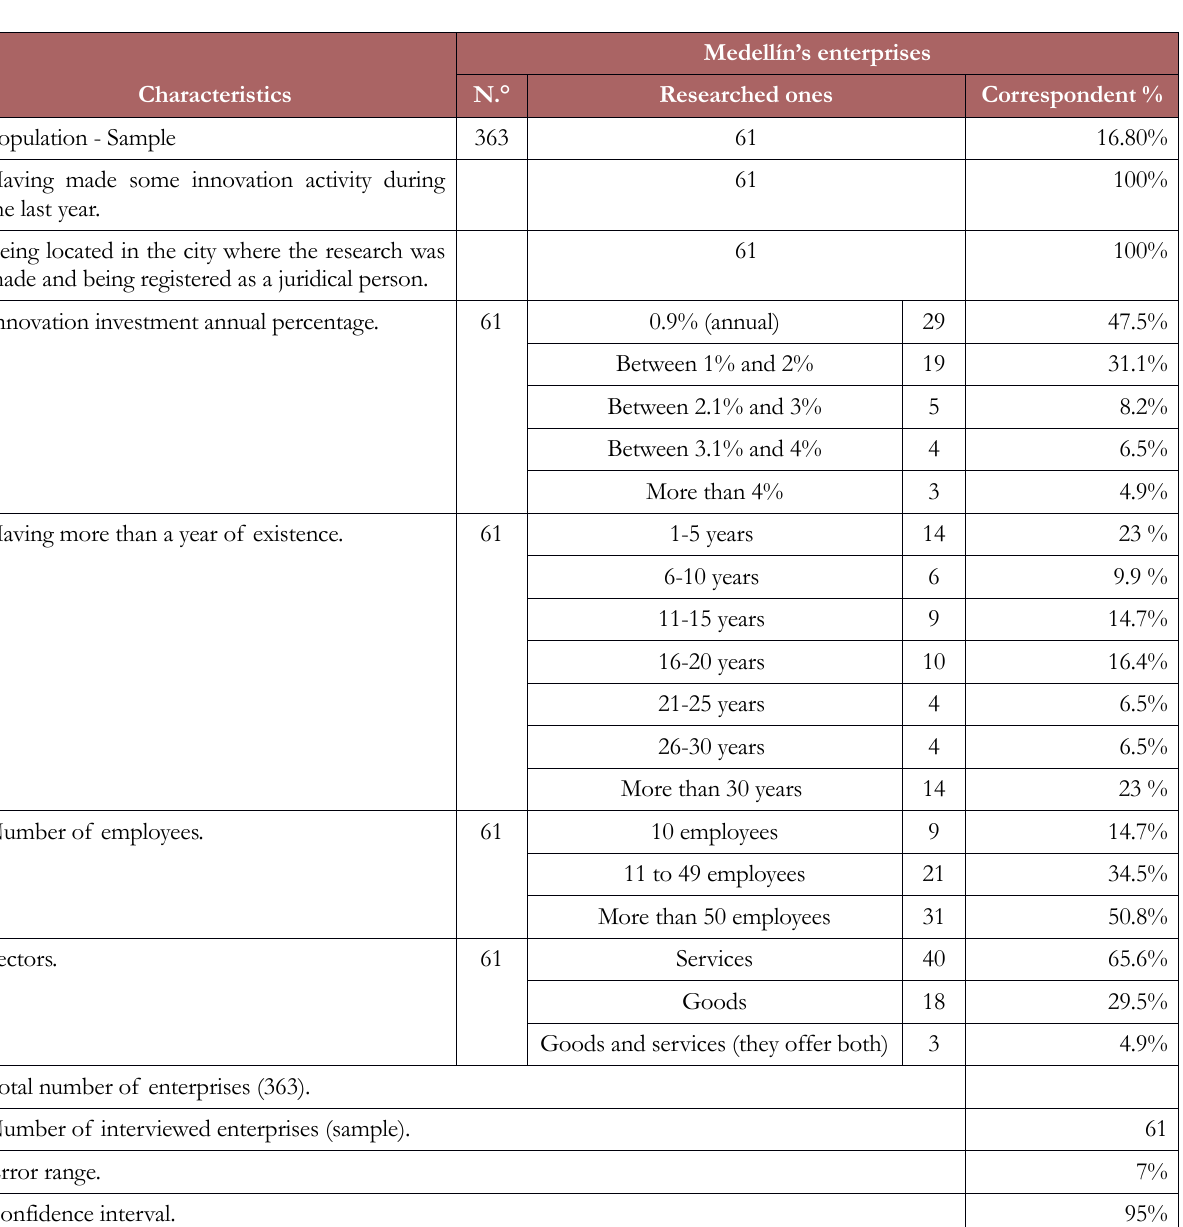
Table 2. Characteristics of innovative enterprises in